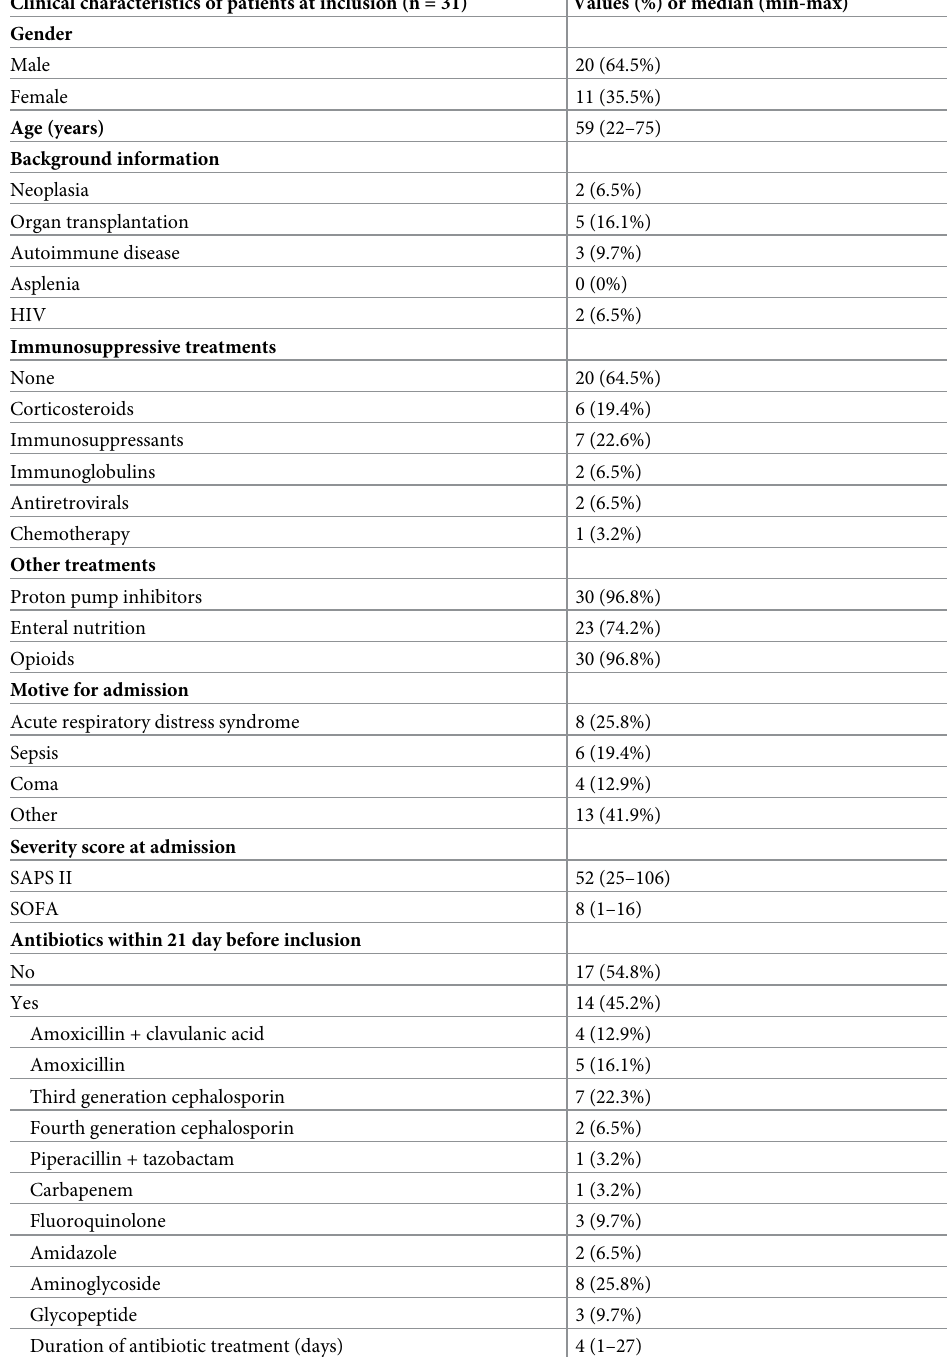
Table 1. Characteristics of the patients (n = 31) included in the study. Clinical characteristics of patients at inclusion (n =